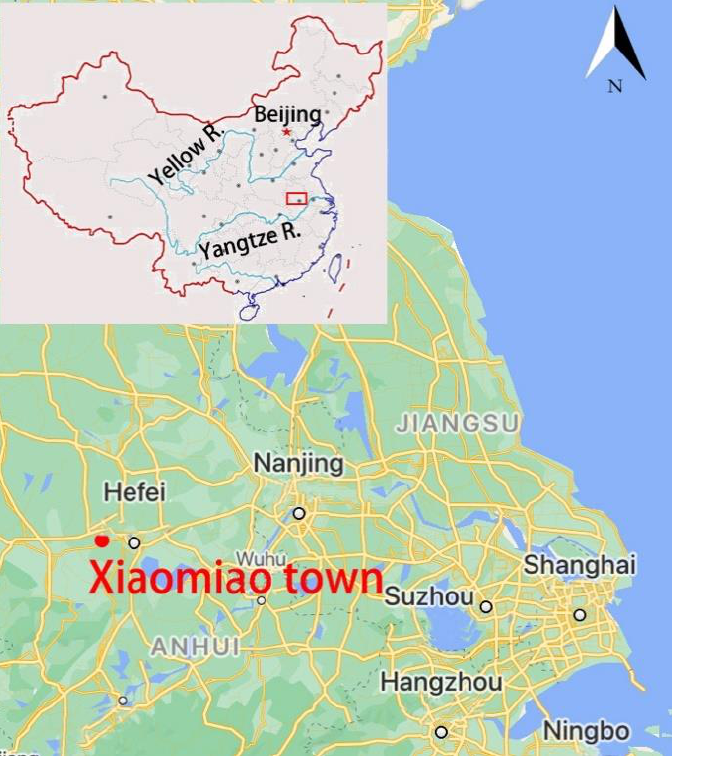
Table 2. Physical and mechanical indexes of expansive soil.